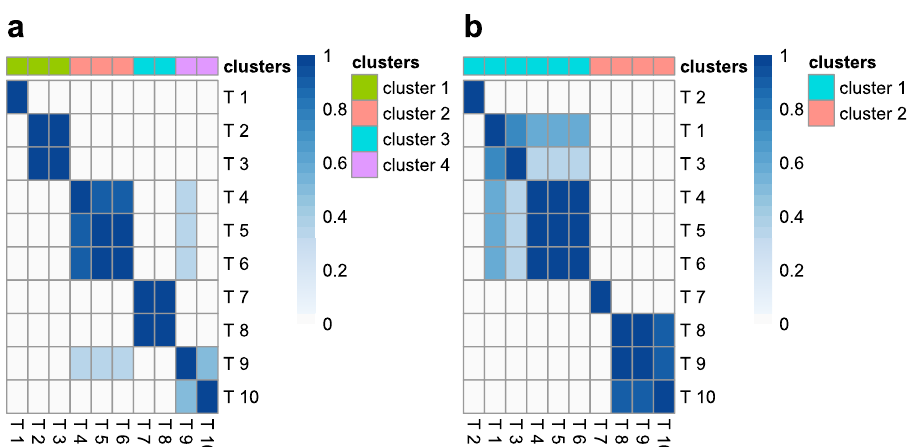
Fig. 7 HyPrColoc ’ s sensitivity analysis. Heatmap visualizing changes in the clusters of colocalized traits identi fi ed by HyPrColoc when using different choices of the colocalization prior p c = {0.05, 0.02, 0.01, 0.005} and algorithm thresholds P (cid:1) R ¼ P (cid:1) A ¼ f 0 : 5 ; 0 : 6 ; 0 : 7 g . Cells appear darker when trait pairs cluster more often. Data were generated under scenario (iii) and when: a the single causal variant assumption is satis fi ed; or b the single causal variant assumption